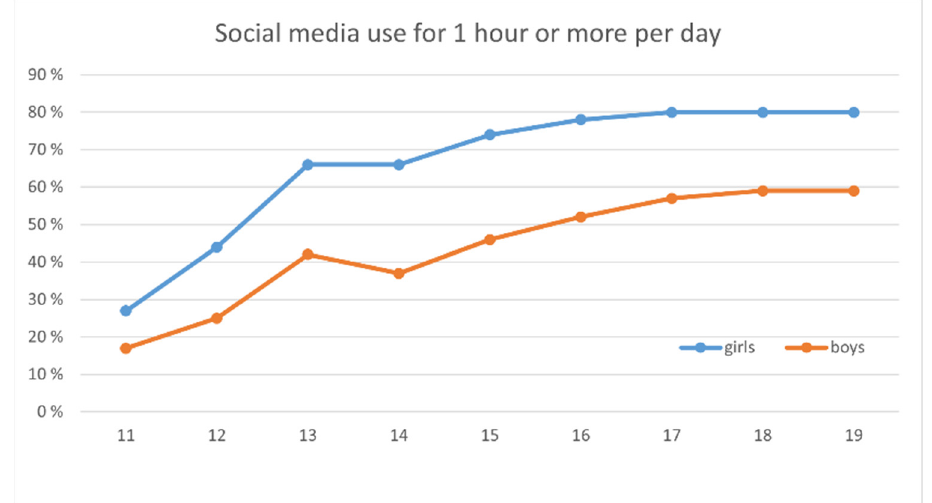
Figure 3. Social media use (one hour or more per day) by age and gender. Gender differences are significant with a p -value of <0.001 for all age groups.